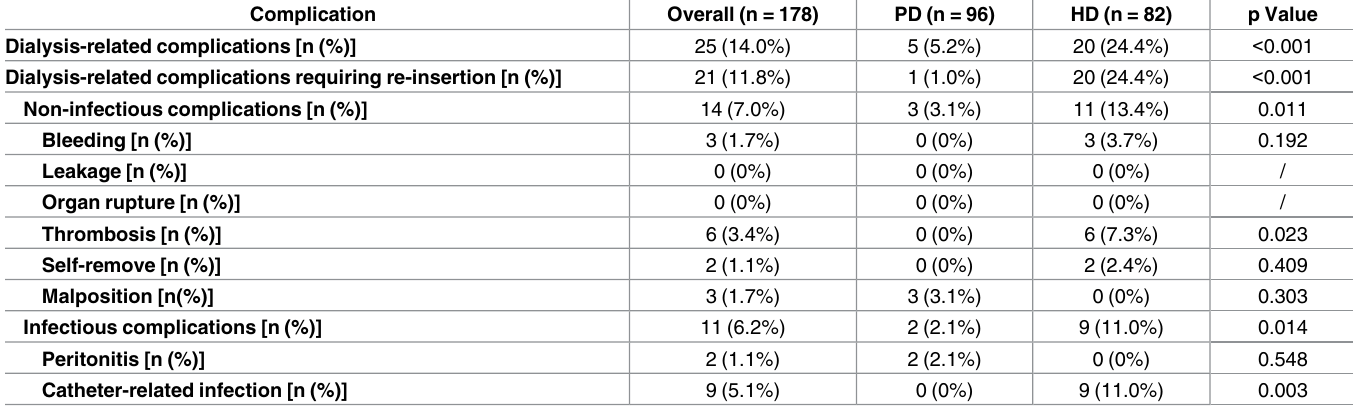
Table 3. Dialysis-related Complications in the Study Groups during a 30-day Period.